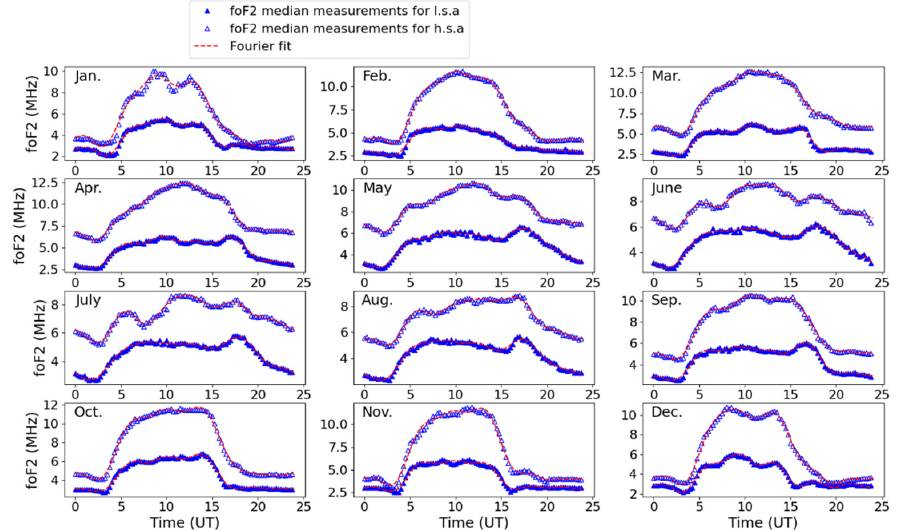
Figure 1. Long-term monthly median foF2 plots for low (2009) and high (2014) solar activity periods with corresponding local (Cyprus CCIR) polynomials (red line).